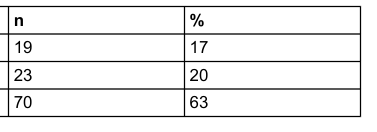
Table 3: Diameter of focal liver lesions (FLLs).